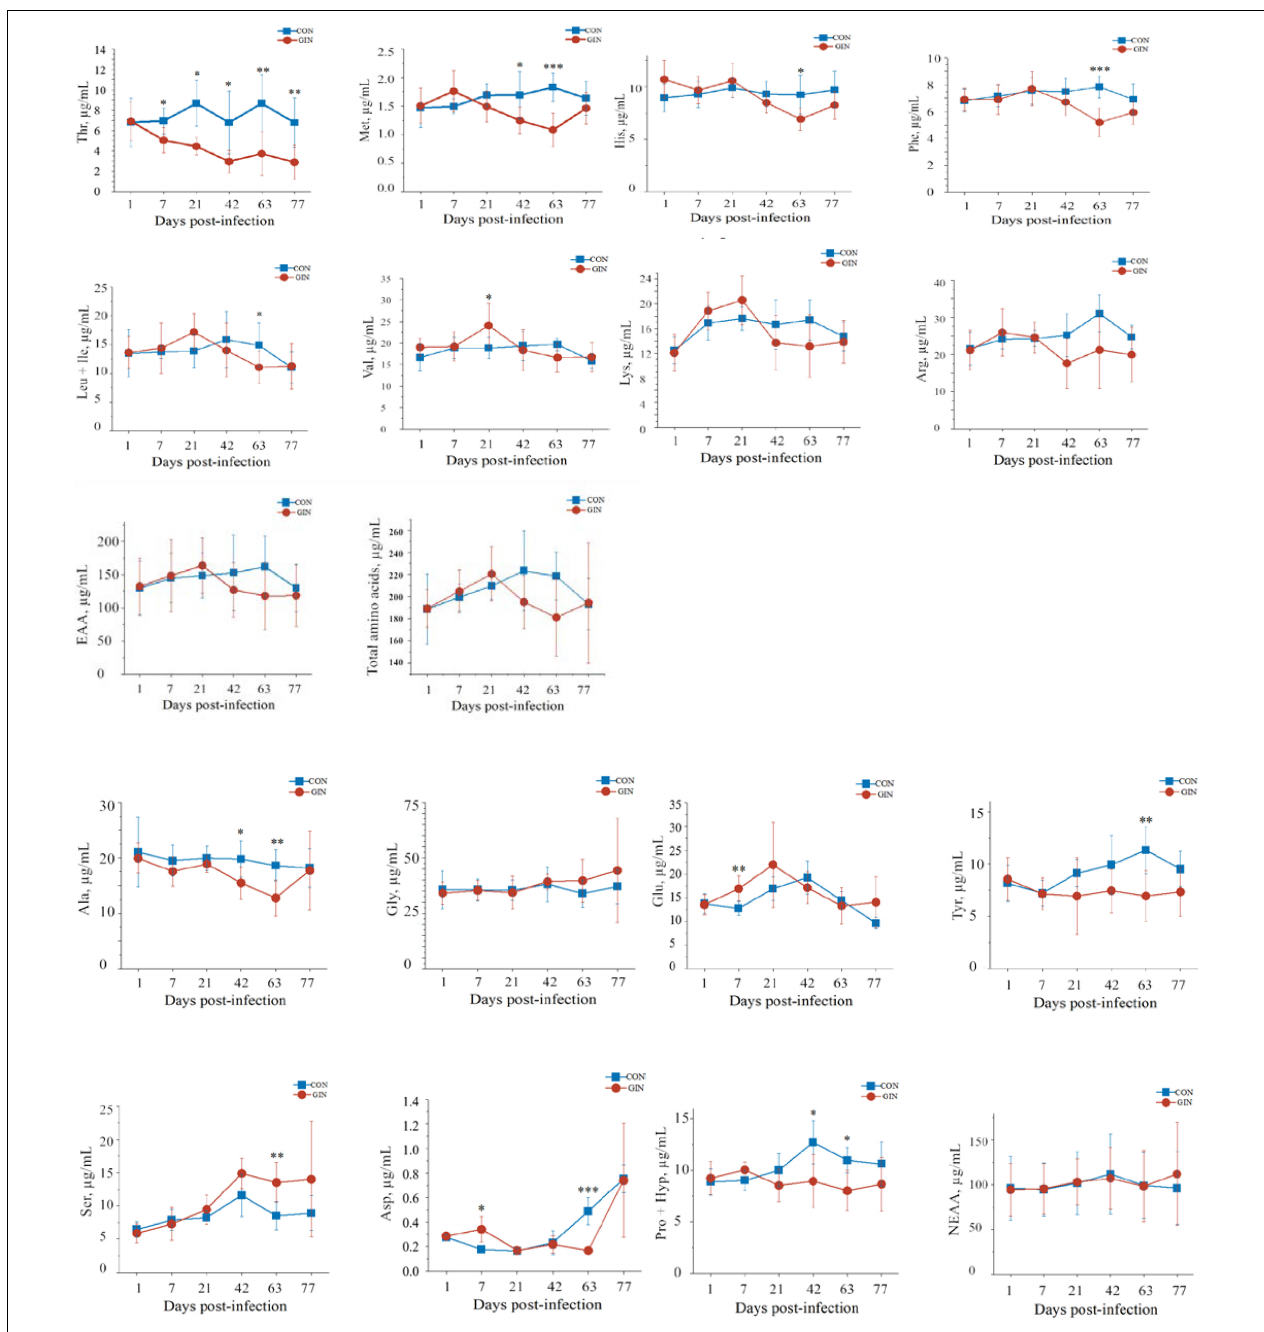
FIGURE 2 | Changes in the plasma free amino acids profile of lambs infected with Haemonchus contortus. ∗ P < 0.05; ∗∗ P < 0.01; ∗∗∗ P <